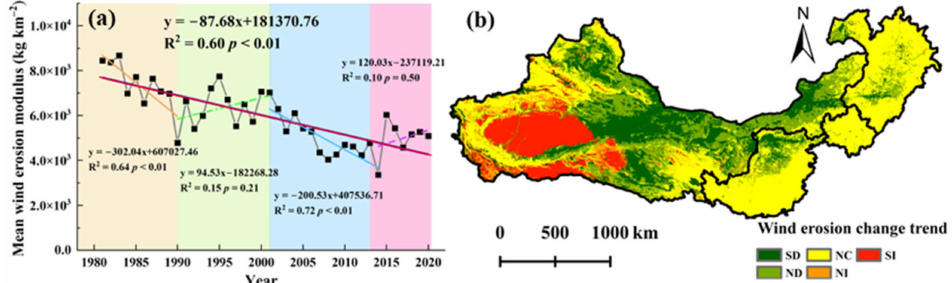
Figure 4. Variation in the wind erosion modulus in the TNR of China from 1981 to 2020. ( a ) Temporal change and ( b ) spatial pattern variation in the wind erosion modulus in the TNR of China from 1981 to 2020. SD: significant decrease; ND: nonsignificant decrease; NC: no change; NI: nonsignificant increase; SI: significant increase.